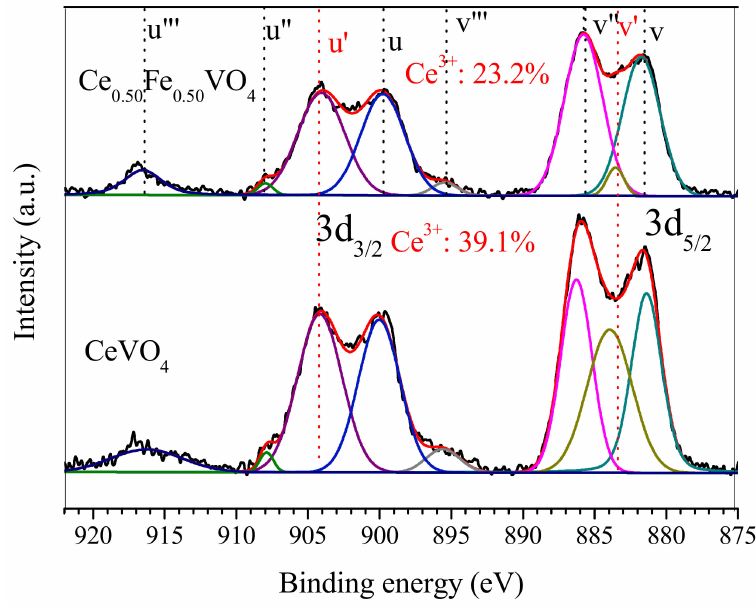
Figure 6. Ce 3d XPS spectra of CeVO 4 and Ce 0.50 Fe 0.50 VO 4 .